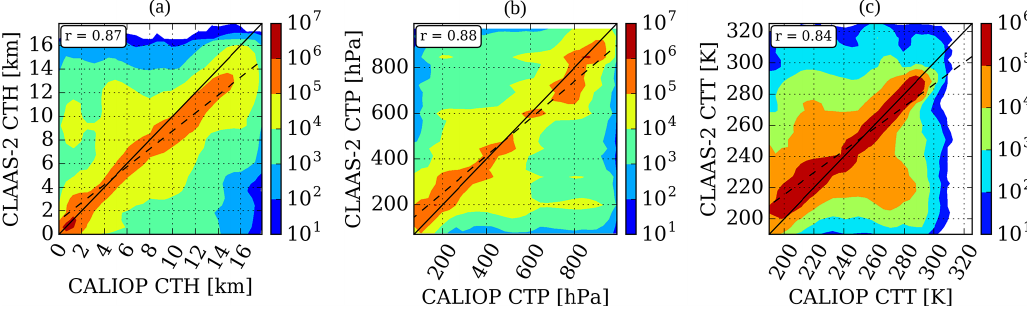
Figure 5. Scatterplots of cloud top products between CLAAS-2 and CALIOP: CTH (a) , CTP (b) and CTT (c) . The diagonal is marked by a solid line, and the dashed lines show the result of a least-squares linear fit. The text box in the upper left corner displays the Pearson correlation coefficient. The p values are practically zero because of the very large number of matchups. CALIOP values were taken from the layer at which ICOT exceeds 0.2 in all